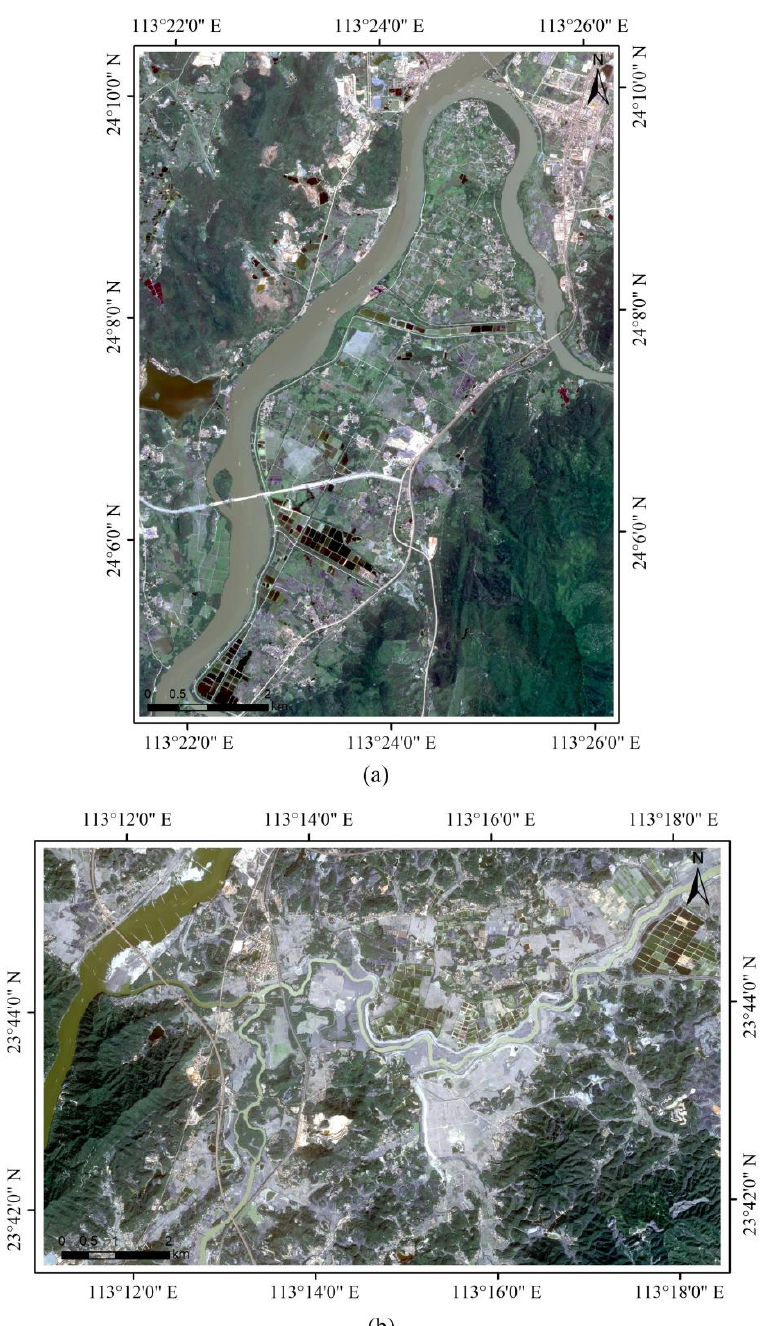
Figure 2. GF-2 images of the two experimental areas: ( a ) Boluokeng; ( b ) Pajiang.